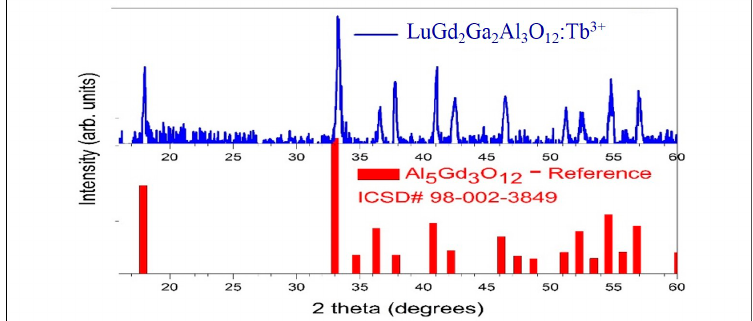
Figure 1. XRD peaks of LuGd 2 Ga 2 Al 3 O 12 :Tb 3 + phosphor and reference peaks of Al 5 Gd 3 O 12